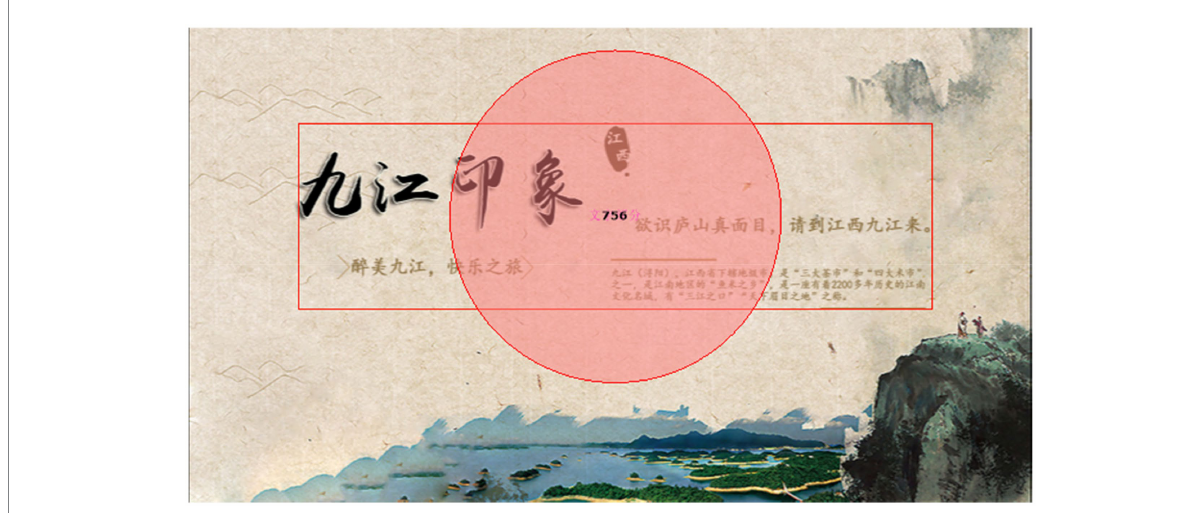
FIGURE 5 Division of area of interest. Source: EyeSo Studio